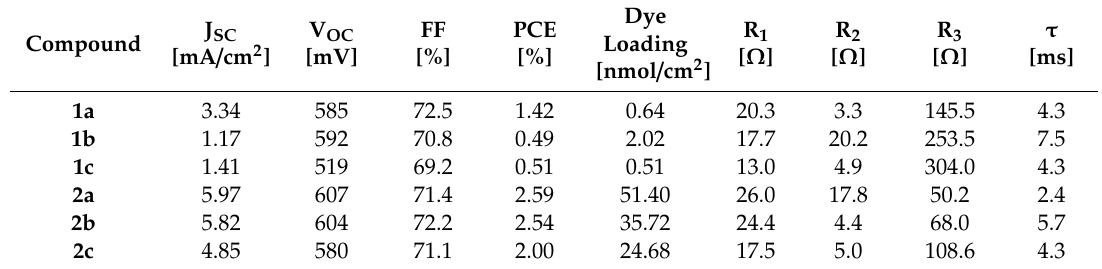
Table 4. The numerical data of the cyclic voltammetry